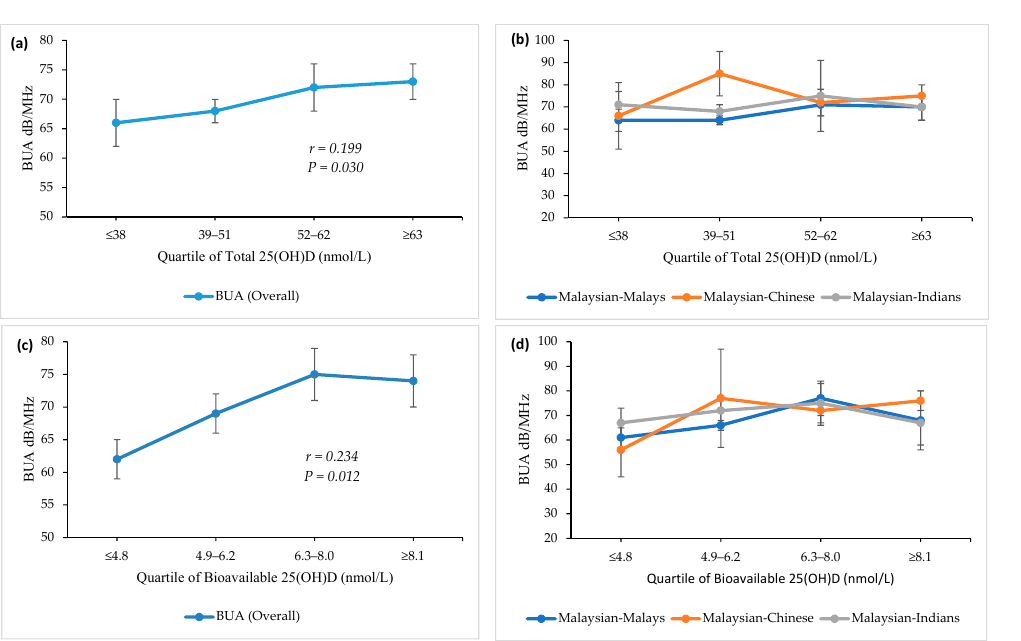
Figure 2. The BUA (broadband ultrasonic attenuation) of participants according to quartiles of Total 25-hydroxyvitamin D: ( a ) The results for all participants; ( b ) the results according to ethnicity: Malaysian-Malays, Malaysian-Chinese and Malaysian-Indians, and Bioavailable 25-hydroxyvitamin D; ( c ) the results for all participants; ( d ) the results according to ethnicity: Malaysian-Malays, Malaysian-Chinese and Malaysian-Indians. Error bar: standard ERROR of